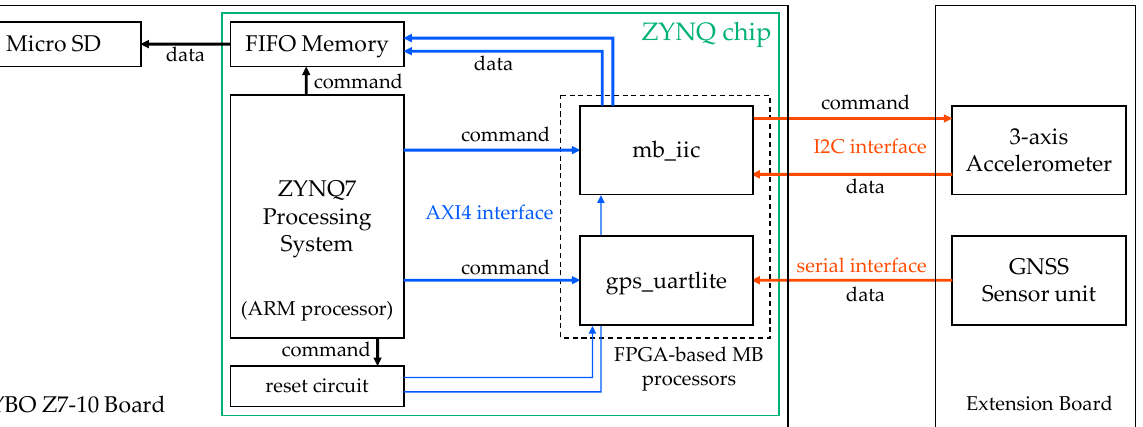
Figure 1. Block diagram of the Zynq chip adopted in the vibration measurement system; this sensor has two FPGA-based MB processors to obtain vibration and position data. MB processors are controlled by the ARM processor on the ZYNQ7 Processing System.